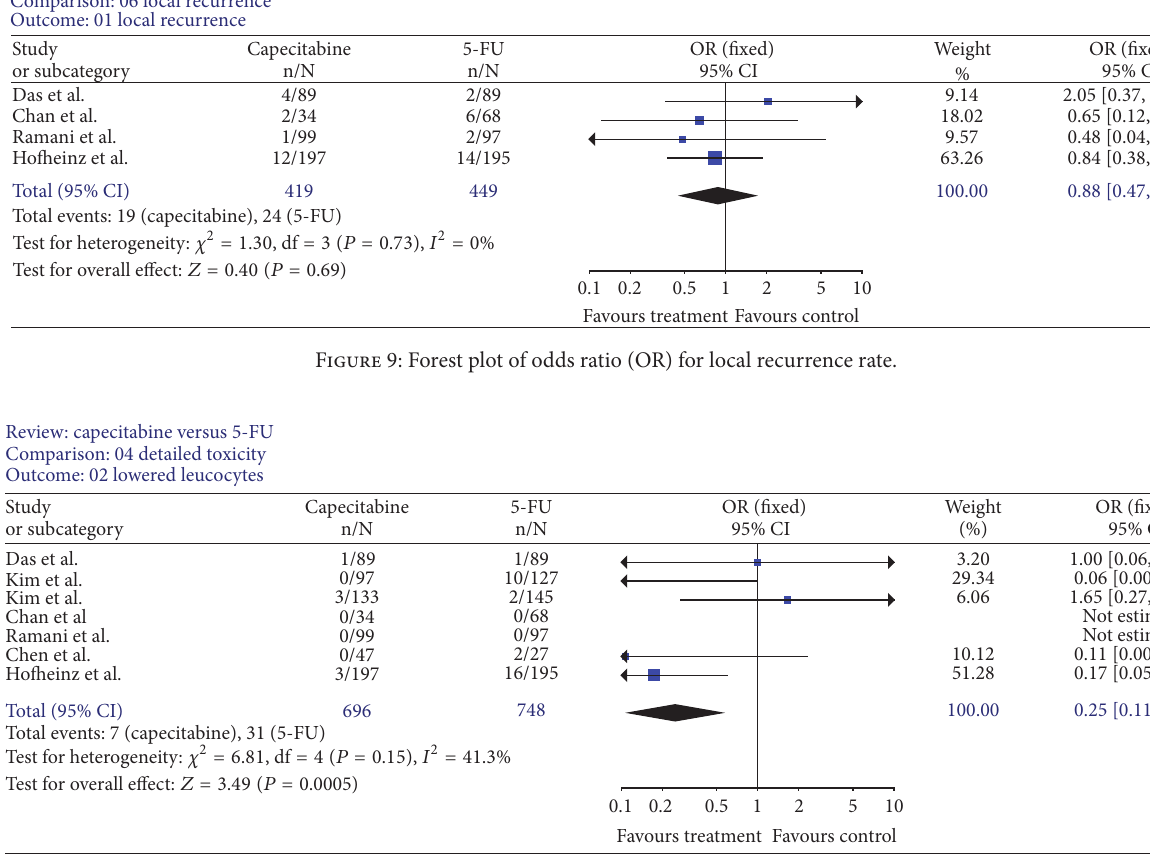
Figure 10: Forest plot of odds ratio (OR) for lowered leucocytes